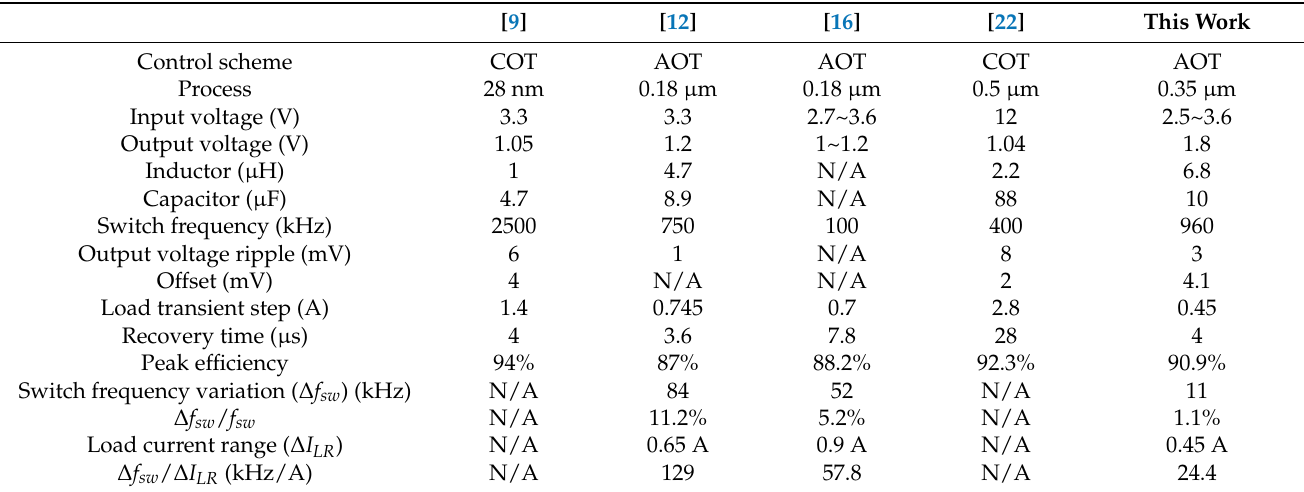
Table 1. Comparison of reported on-time controlled buck